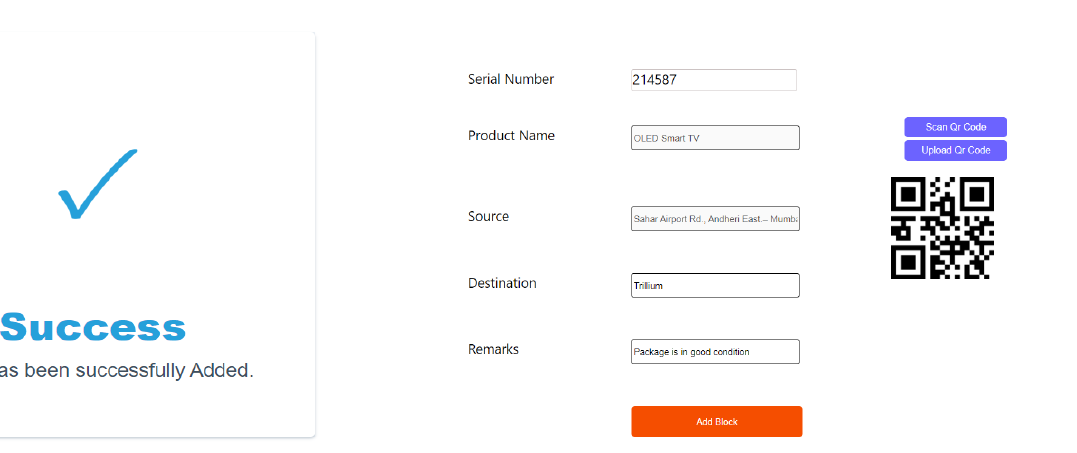
Figure 8: Manufacturer Login page